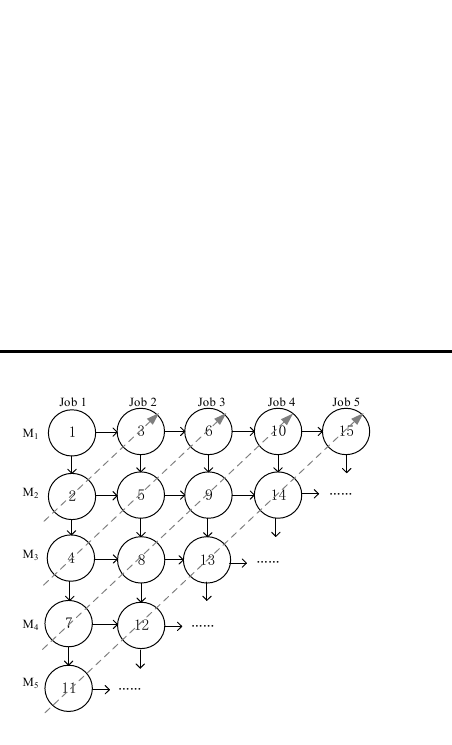
Fig. 4. Illustration of BMJ